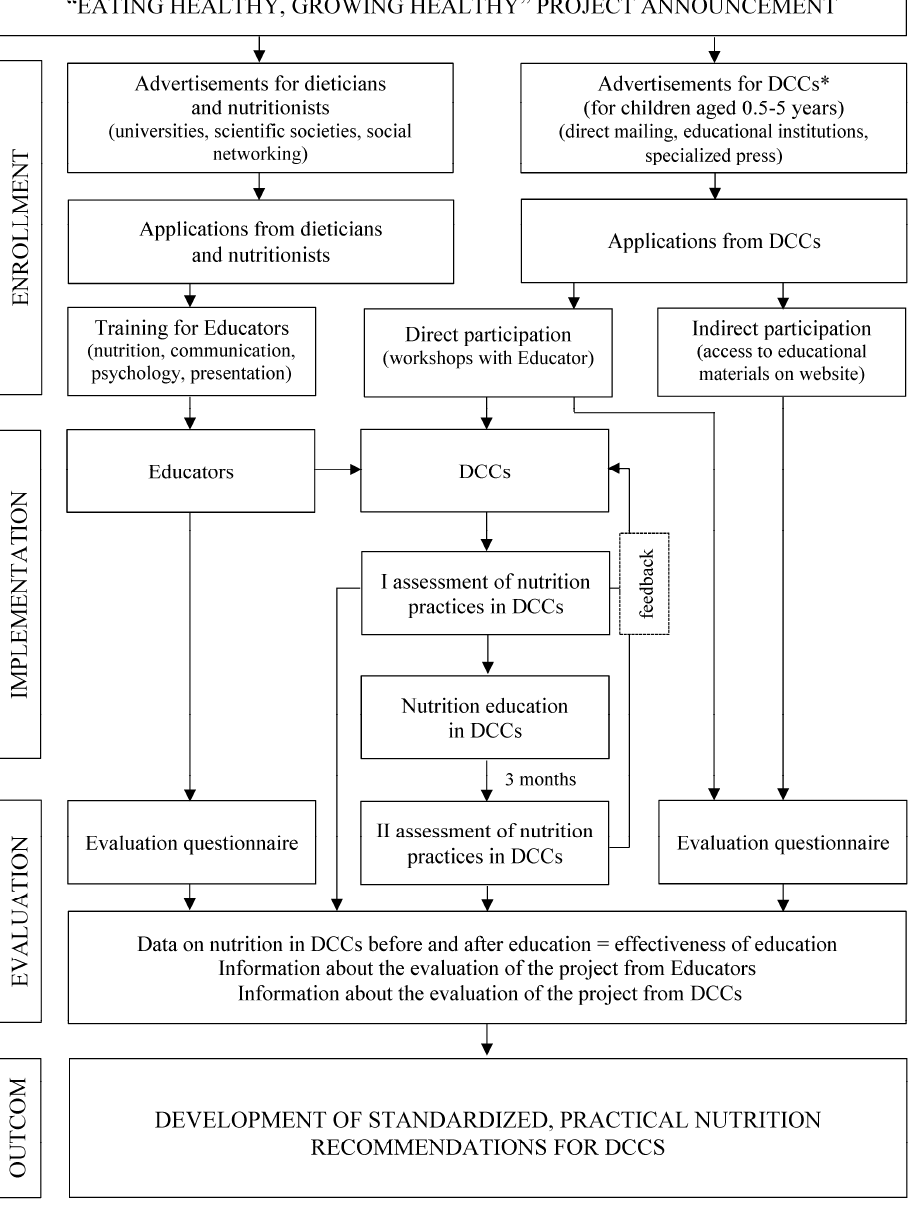
Figure 1. The overview of the project Eating healthy, growing healthy. * DCCs—day care centers.